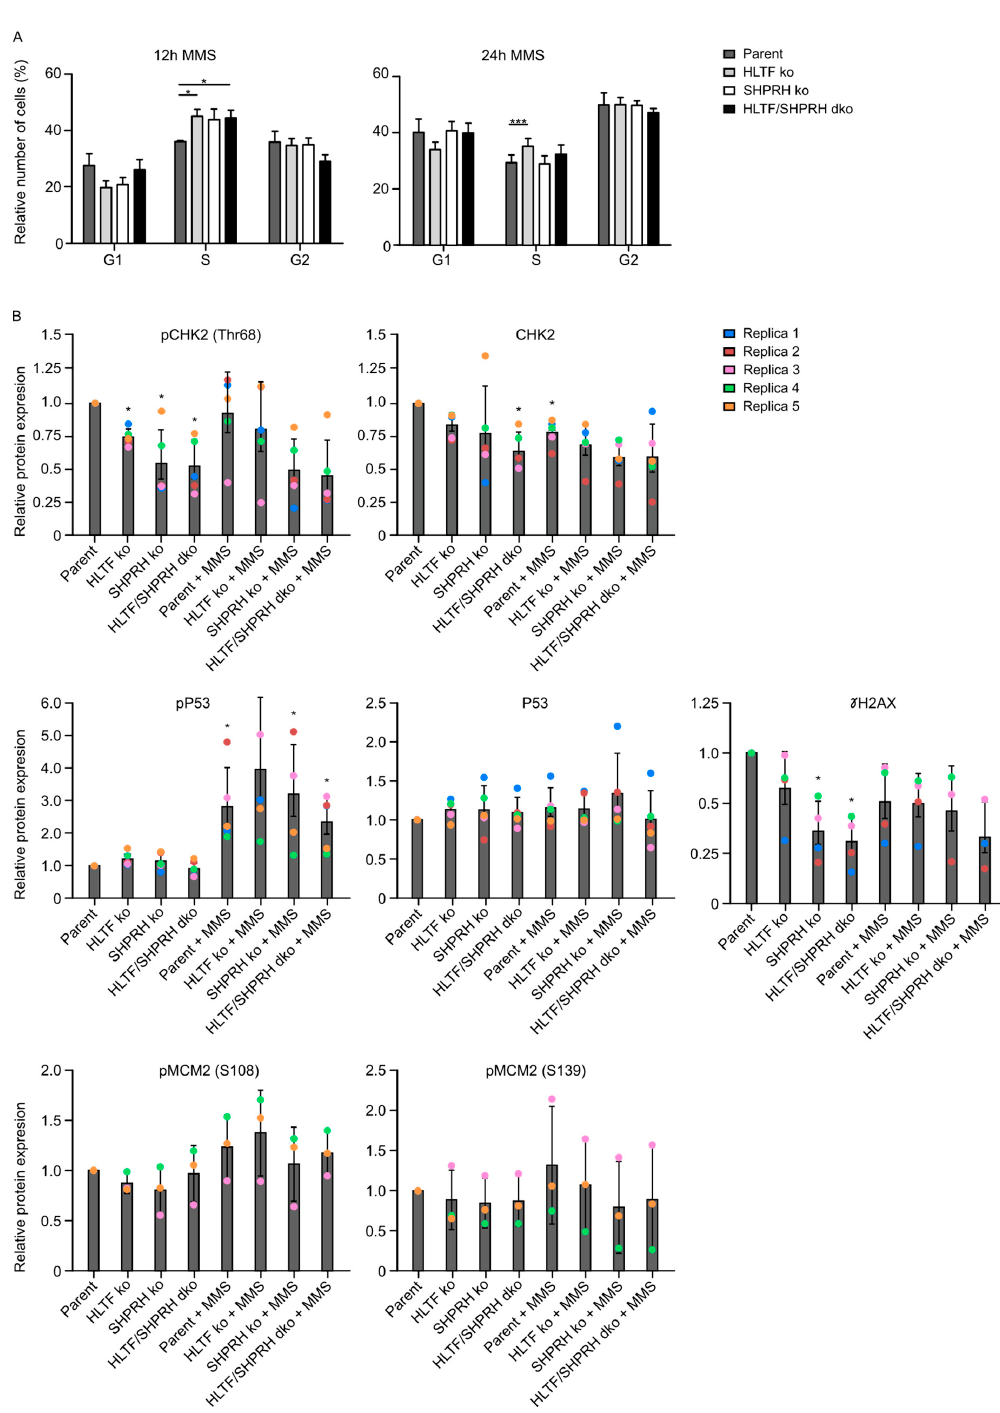
Figure 5. Di ff erent cell cycle distribution after MMS in ko cell lines. ( A ) Cell cycle analysis of knockout cell lines and parent Hap1 cell line 12 and 24 h after MMS treatment; 4 and 5 replica, respectively. Student’s t -test * p < 0.05, *** p < 0.001. ( B ) Levels of pCHK2 T68, CHK2, p53-P, p53, pMCM2-S139, pMCM2 S108 and γ H2AX before and after MMS (50 µ M) treatment (12 h) in di ff erent cell lines relative to the level in untreated parent cells. Level of protein detected by Western blot analysis are determined using fluorescence and loading is normalized to β -actin. One representative blot is shown in Figure A3 (Appendix A). Average ± SD as well as individual values of 3–5 replica (R1-R5) are shown. Student’s t -test compared to untreated parent cell line * p <